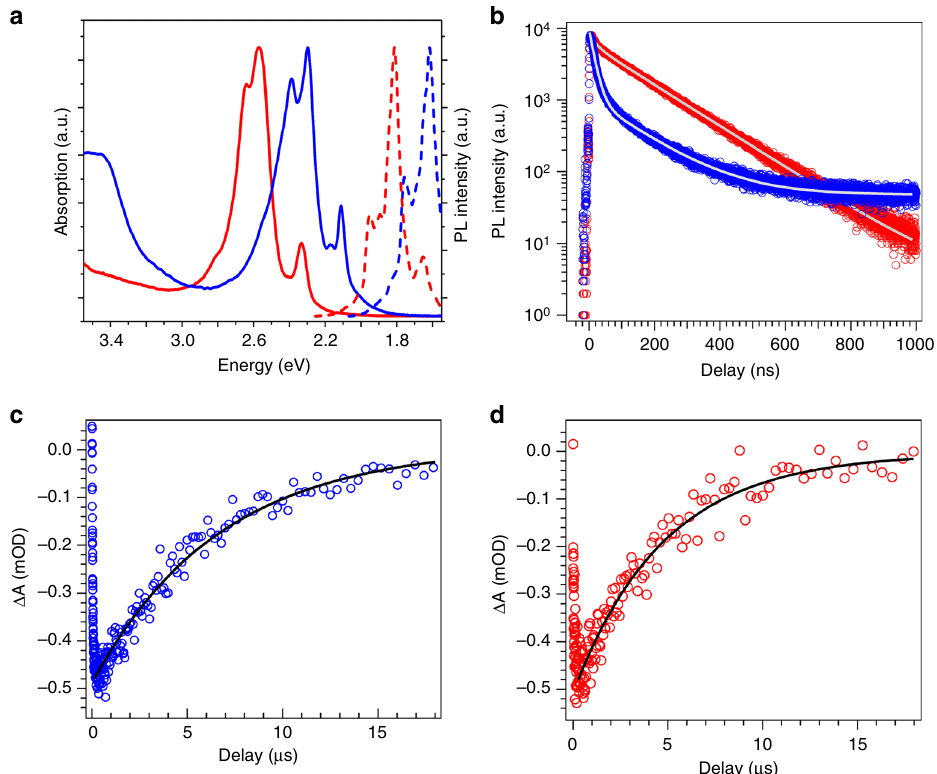
Fig. 4 Optical properties of molecular bilayer graphenes. a Absorption (solid line) and emission (dashed line) spectra of 1 (blue) and 2 (red). b Time- resolved fl uorescence kinetics of 1 (blue, monitored at 767 nm) and 2 (red, monitored at 683 nm). The average lifetime of 1 and 2 is 28.5 and 118 ns. c , d Transient absorption kinetics of c 1 and d 2 monitored at their respective fi rst vibronic peak